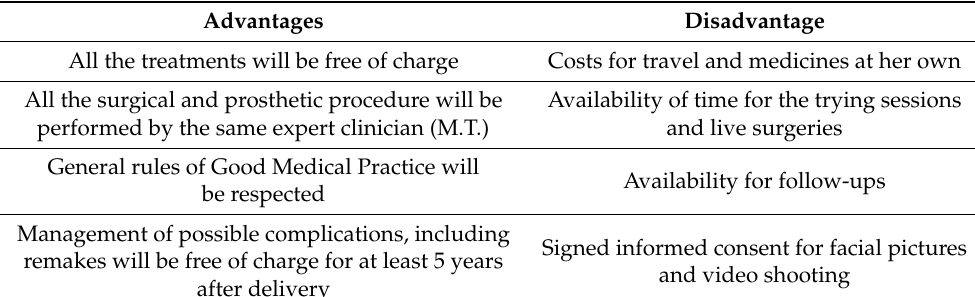
Table 2. Advantages and disadvantages proposed to the patient.